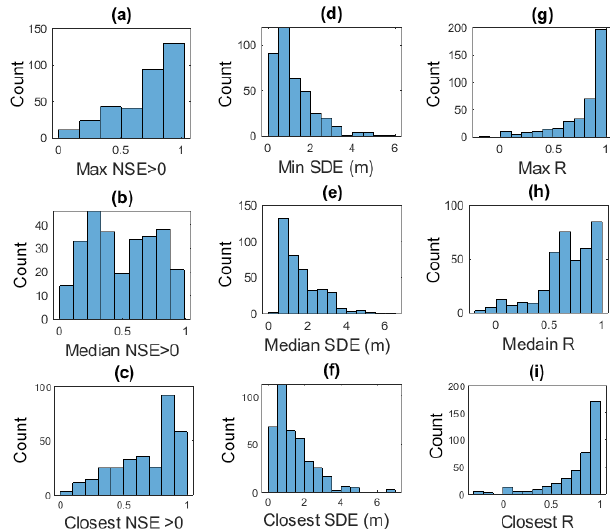
Figure 3. Virtual station fit statistics computed with all available evaluation gages located in the same river and closest comparison. Please note that NSE values are plotted here only when greater than 0 to enable readers to more easily see the majority of the data. A to- tal of 12.2, 28.8, and 17.2% of the total data are not shown in panel (a) , (b) , and (c) respectively. (a) Histogram of the max NSE > 0 at each VS in the dataset, (b) histogram of the median NSE > 0 at each VS in the dataset, (c) histogram of the closest NSE > 0, (d) histogram of the minimum SDE in the dataset, (e) histogram of the median SDE of all the VSs in the dataset, (f) histogram of the closest SDE, (g) histogram of the max R at each VS in the dataset, (h) histogram of the median R at each VS in the dataset, and (i) his- togram of closest R